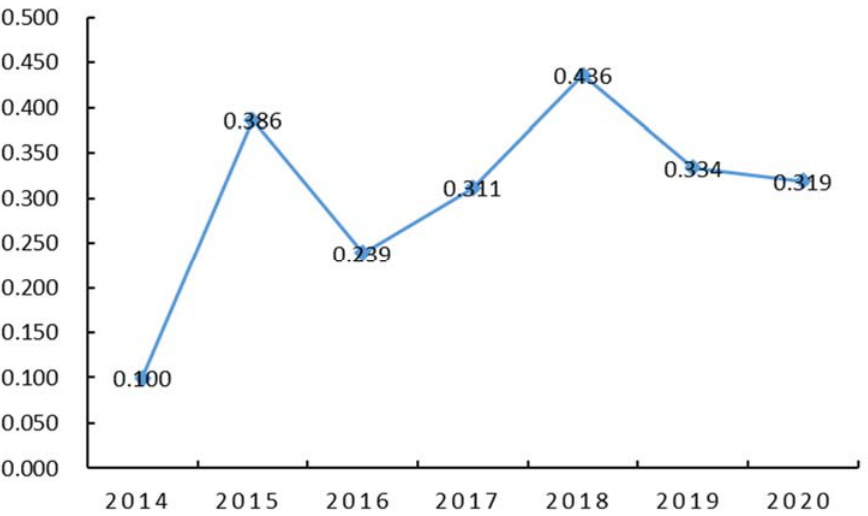
Figure 4. The synergy degree of the WCG system of Taihu Basin among cities during 2014–2020.